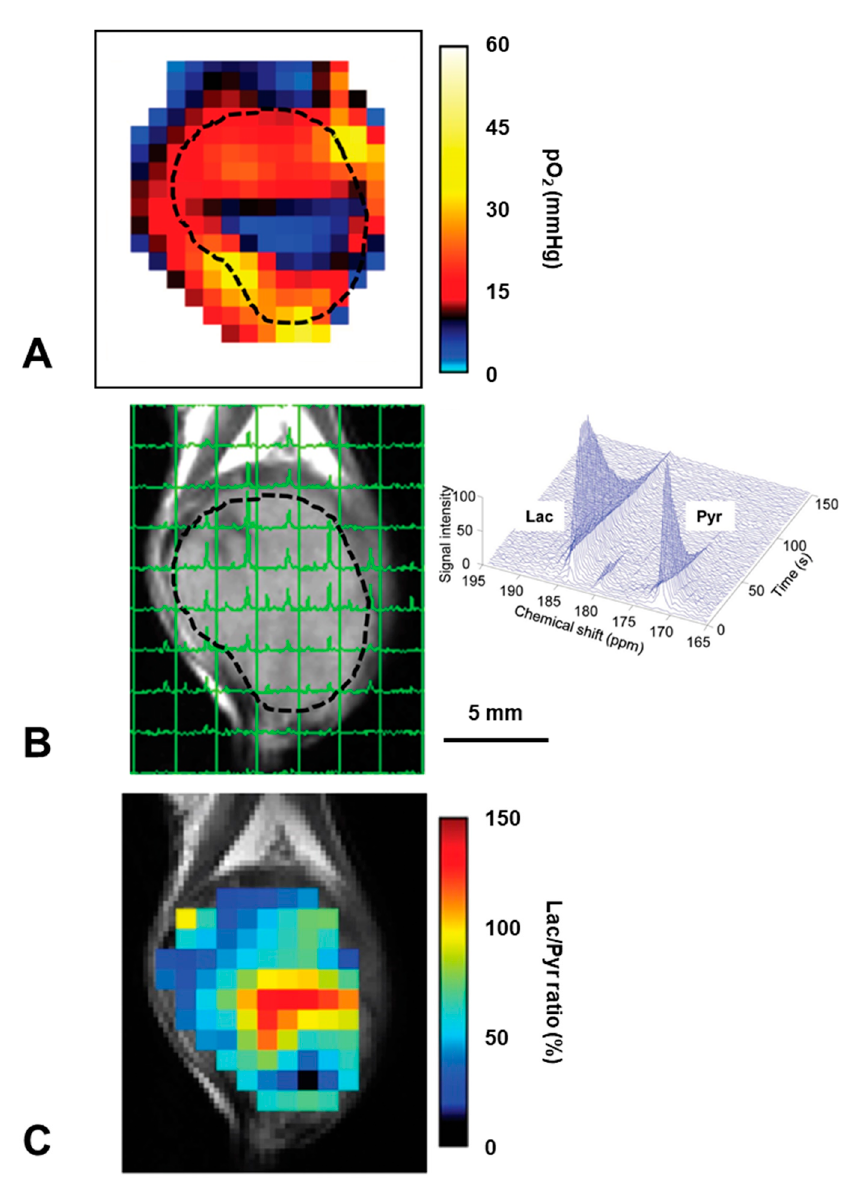
Figure 14. Comparison of the hypoxic region and glycometabolic shift in a SCCVII tumor on a mouse leg. ( A ) The pO 2 map obtaine by pulsed EPR oxygen imaging shows a hypoxic core (blue) in the central part of the tumor. ( B ) Chemical shift imaging obtained by 13 C-DNP MRI 12 sec after hyperpolarized 13 C-labeled pyruvate injection is overlaid on the T 2 -weighted image. Each signal peak (green line) corresponds to pyruvate (right) and lactate (left), respectively. ( C ) The lactate/pyruvate ratio map shows higher lactate/pyruvate ratio area dominantly exists in the hypoxic region on EPRI. The figure was partly modified from our previous report [136].